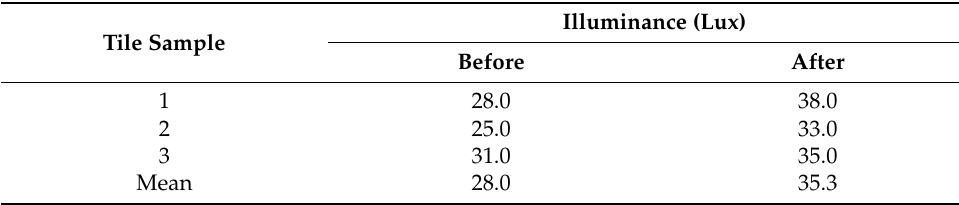
Table 27. Illuminance before and after the floor is polished.